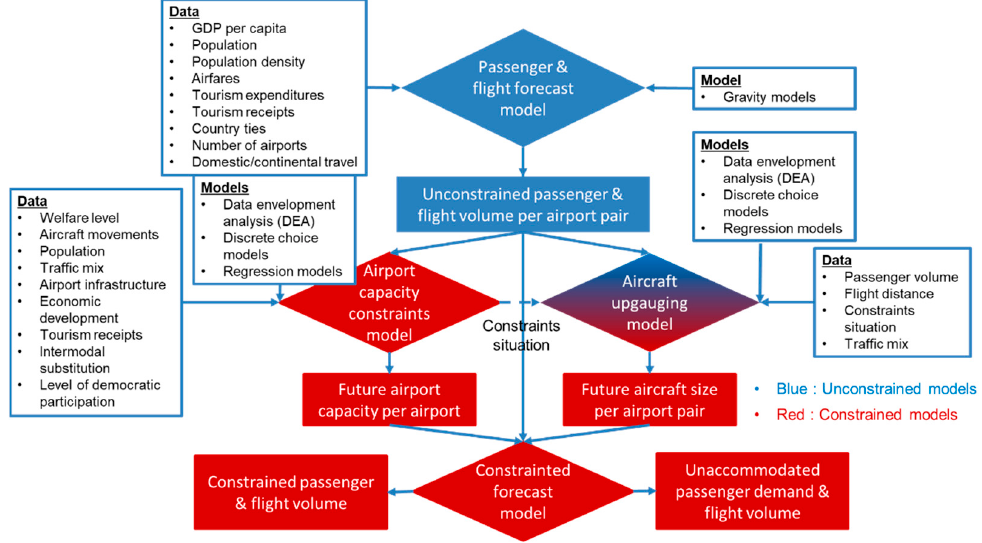
Figure 1. Overview of the passenger and flight forecast model.